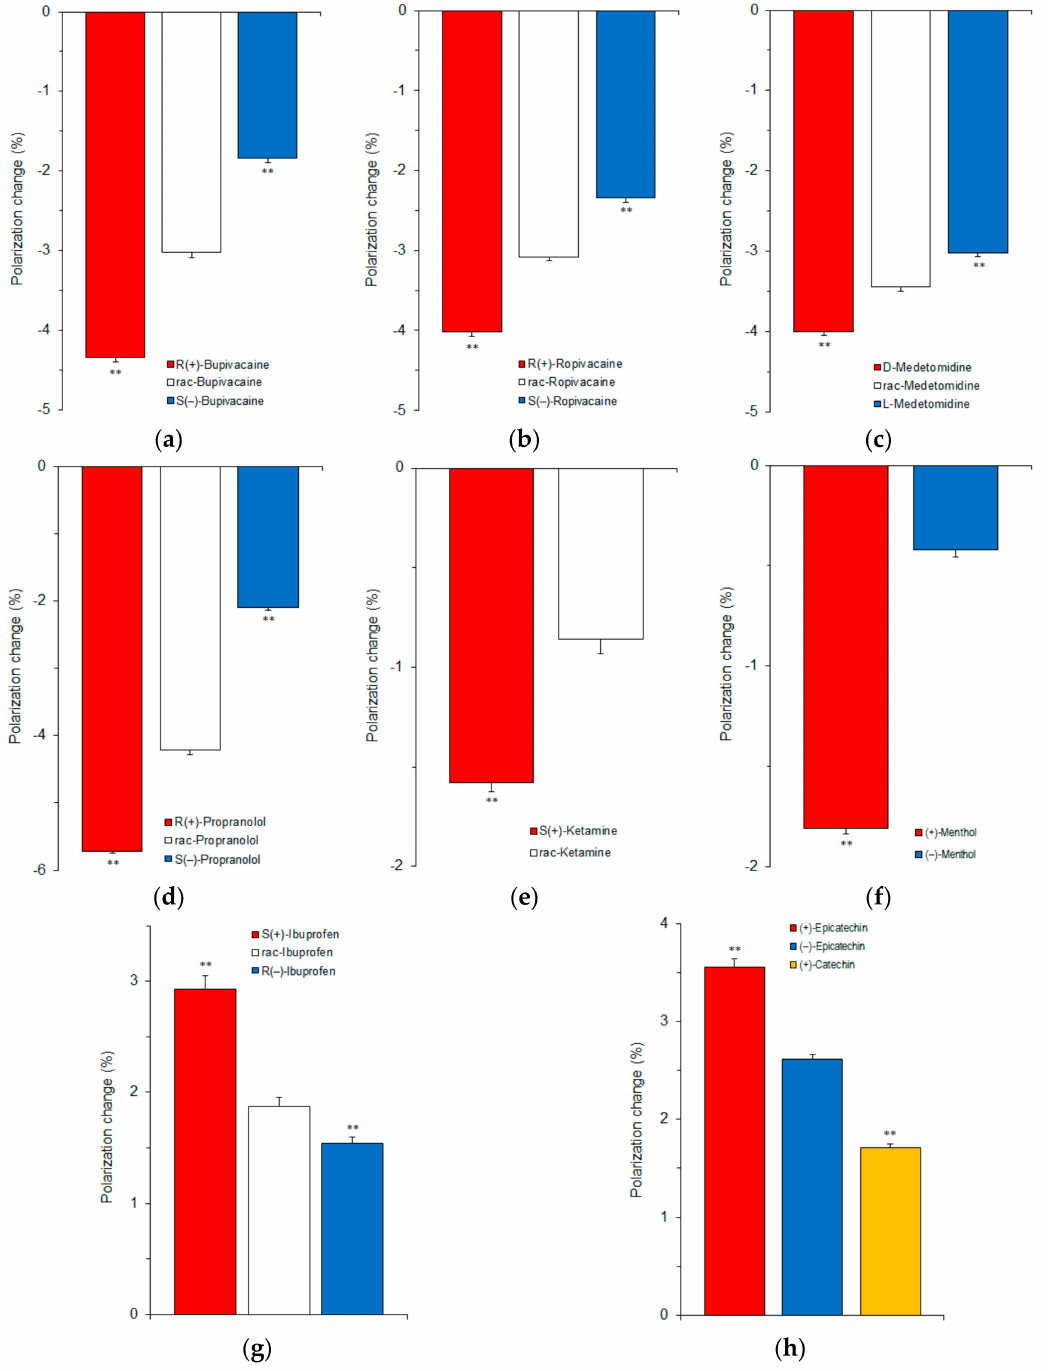
Figure 6. Membrane interactions of stereoisomers of 25 µ M bupivacaine ( a ); 50 µ M ropivacaine ( b